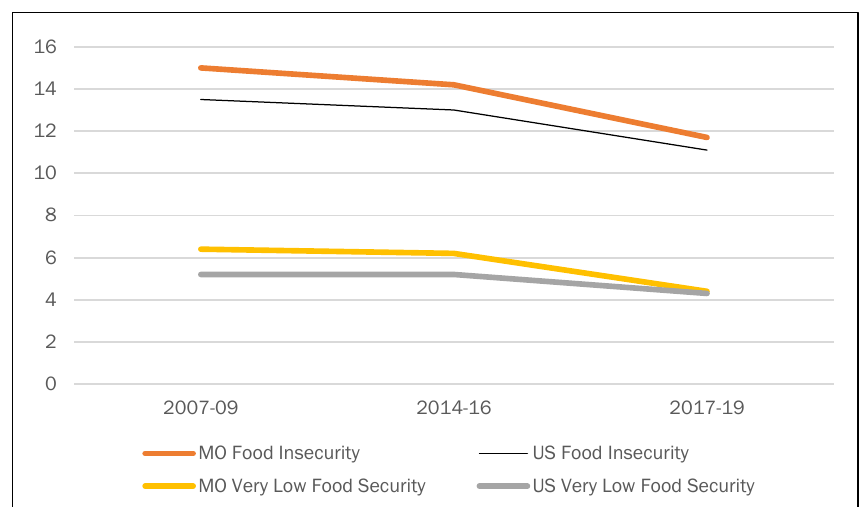
Figure 6. Missouri and U.S. Food Insecurity, 2007 –